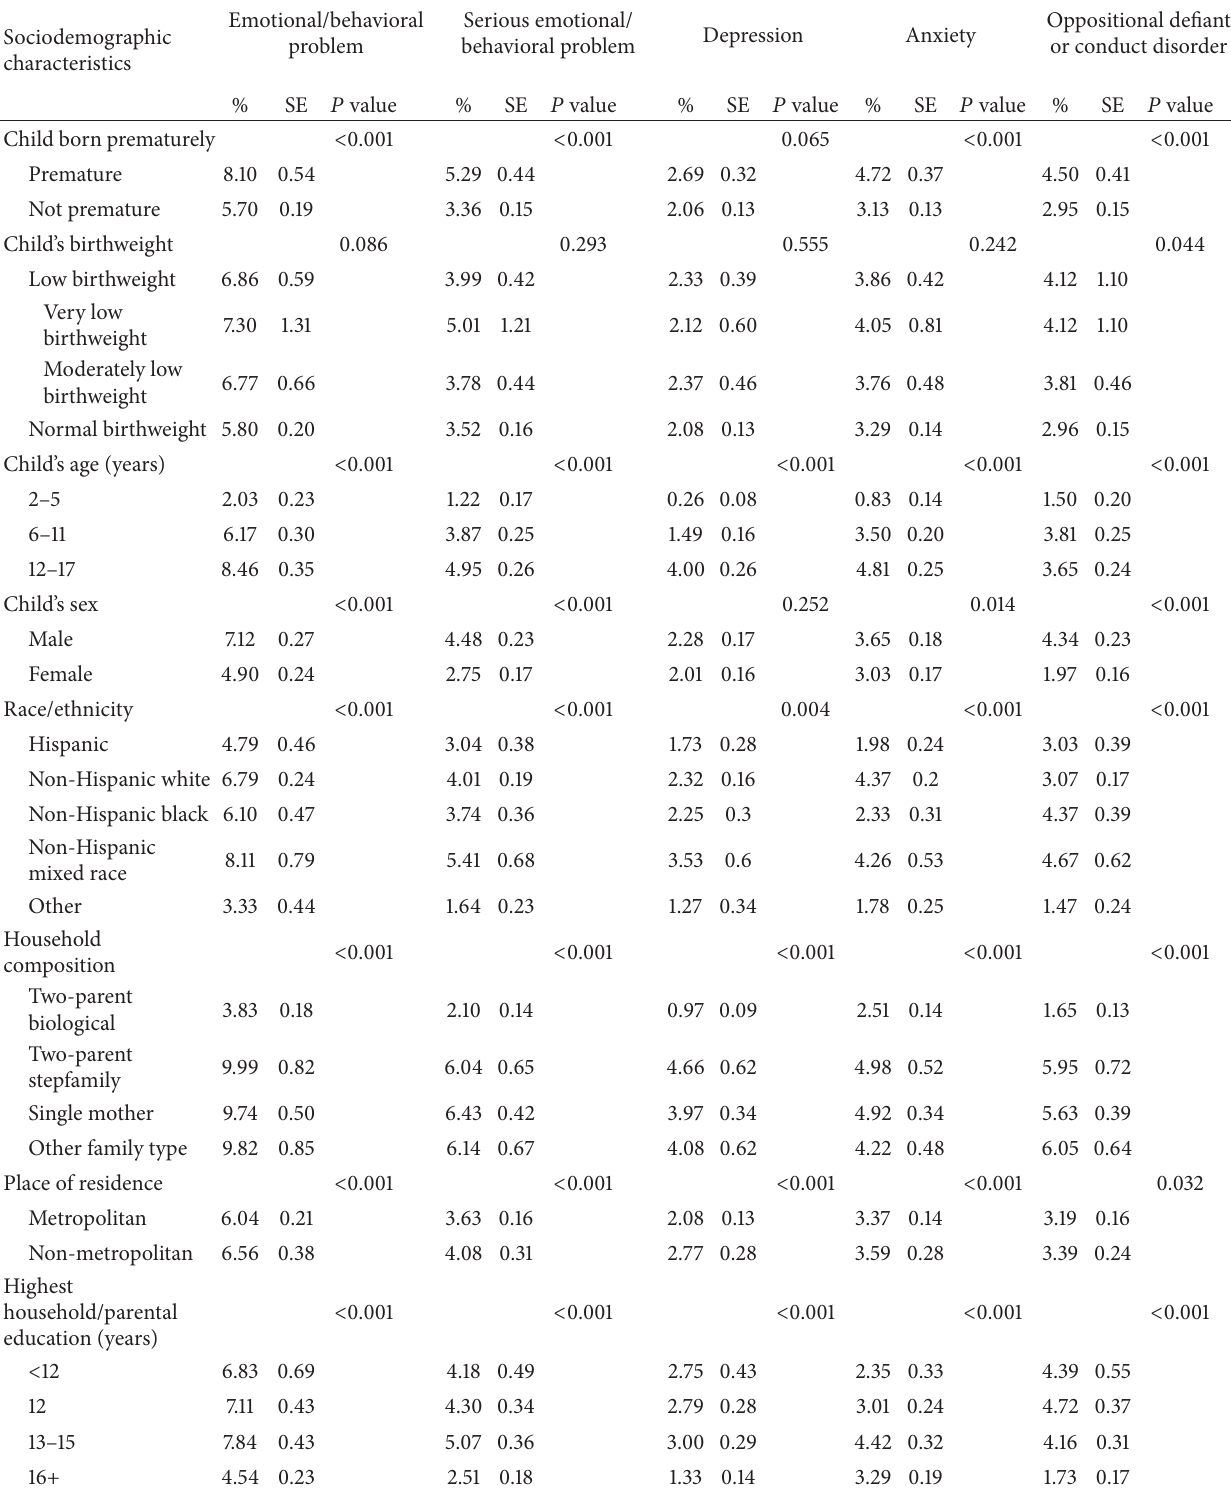
Table 3: Weighted prevalence of selected mental health outcomes among US children aged 2–17 years by perinatal and sociodemographic characteristics: the 2011-2012 National Survey of Children’s Health ( 𝑁 =